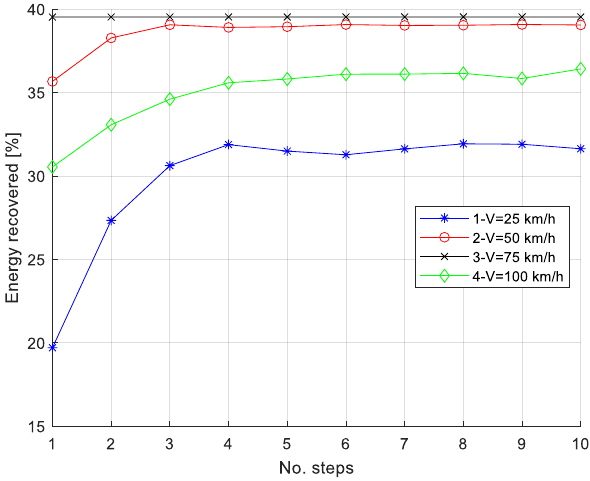
Figure 8. Fraction of energy recovered with a stopping time of 20 s, starting from 25 km/h to 100 km/h.